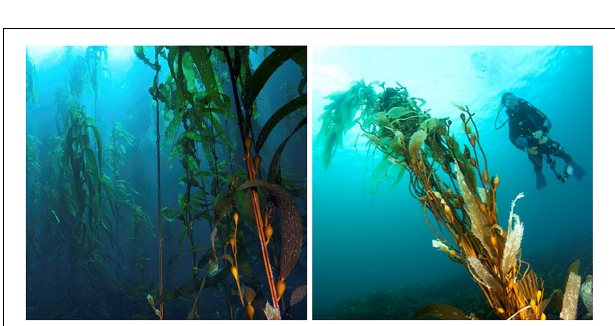
FIGURE 2 | Examples of healthy (left) and degraded (right) giant kelp ( Macrocystis pyrifera ) forests in Tasmania. Photos reproduced with permission of Matthew Ramaley (left) and Matthew Doggett (right)